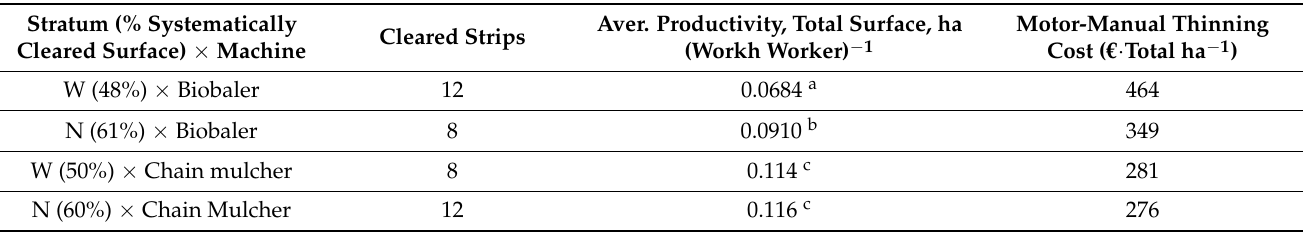
Table 6. Total manual cleared area per hour and operator in each technology and working method (the different letters indicate statistically significant differences at 95% probability). Acronyms: N, narrow; W, wide; Workh, workhour; ha, hectare (the different superscript letters indicate statistically significant differences at 95% probability). Stratum (%